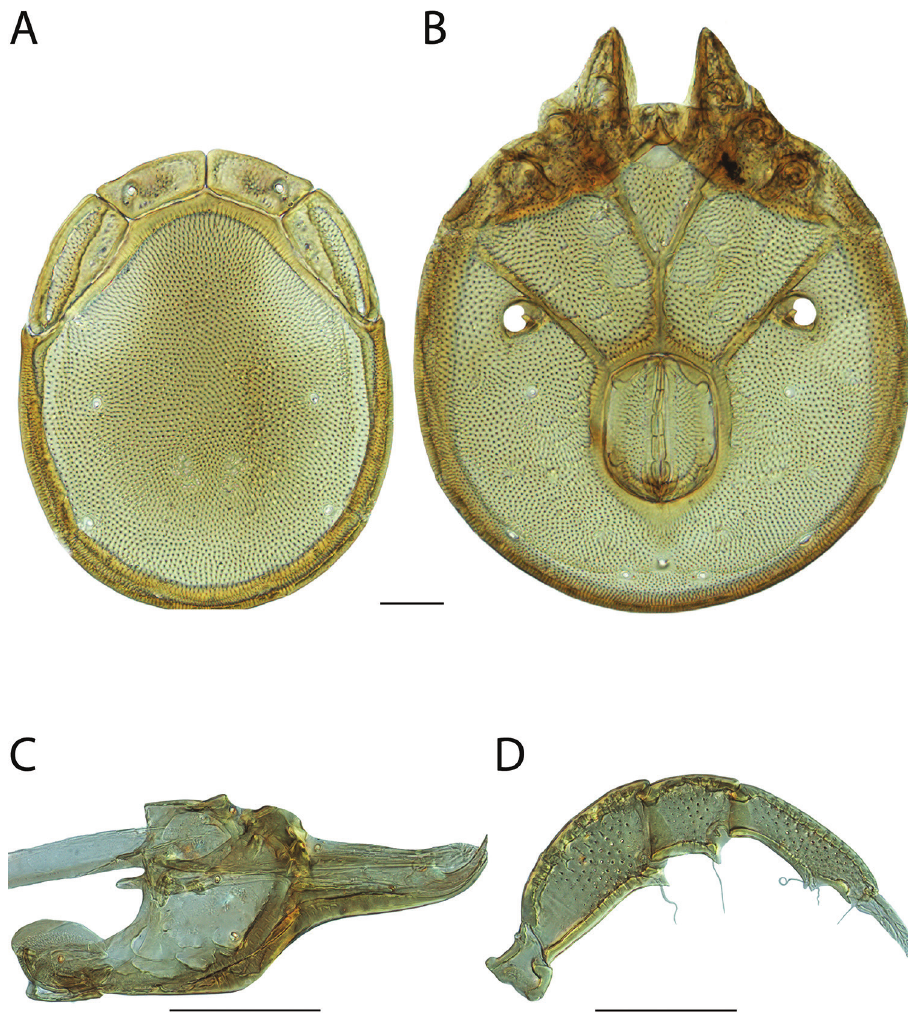
Figure 60. Torrenticola dolichodactyla sp. n. male: A dorsal plates B venter (legs removed) C subcapitulum D pedipalp (setae not accurately depicted). Scale = 100